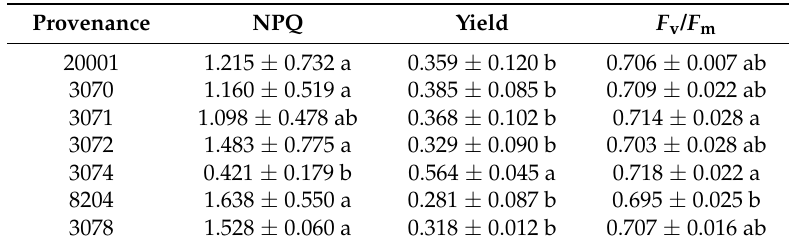
Table 8. Values of chlorophyll fluorescence parameters among teak clones from different provenances.